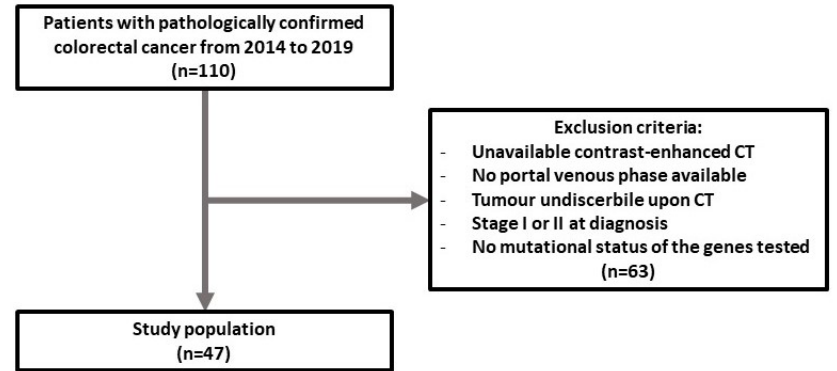
Figure 2. Flow chart of the enrolled population. Table 1. Demographic and clinical–pathological characteristics of the studied population. Characteristics